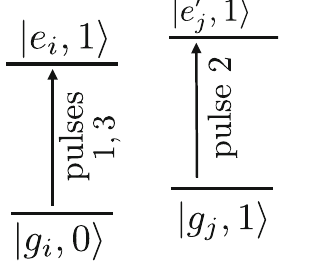
Fig. 16 The Cirac–Zoller scheme. We shine three laser pulses. The first pulse transfers the population in | g i , 0 (cid:7) to | e i , 1 (cid:7) , creating one phonon in the process. The second pulse gives a ( − 1 ) sign to | g j , 1 (cid:7) , thus realizing a controlled-Z gate between the ion and the phonon. The third pulse is identical to the first pulse, destroying the phonon